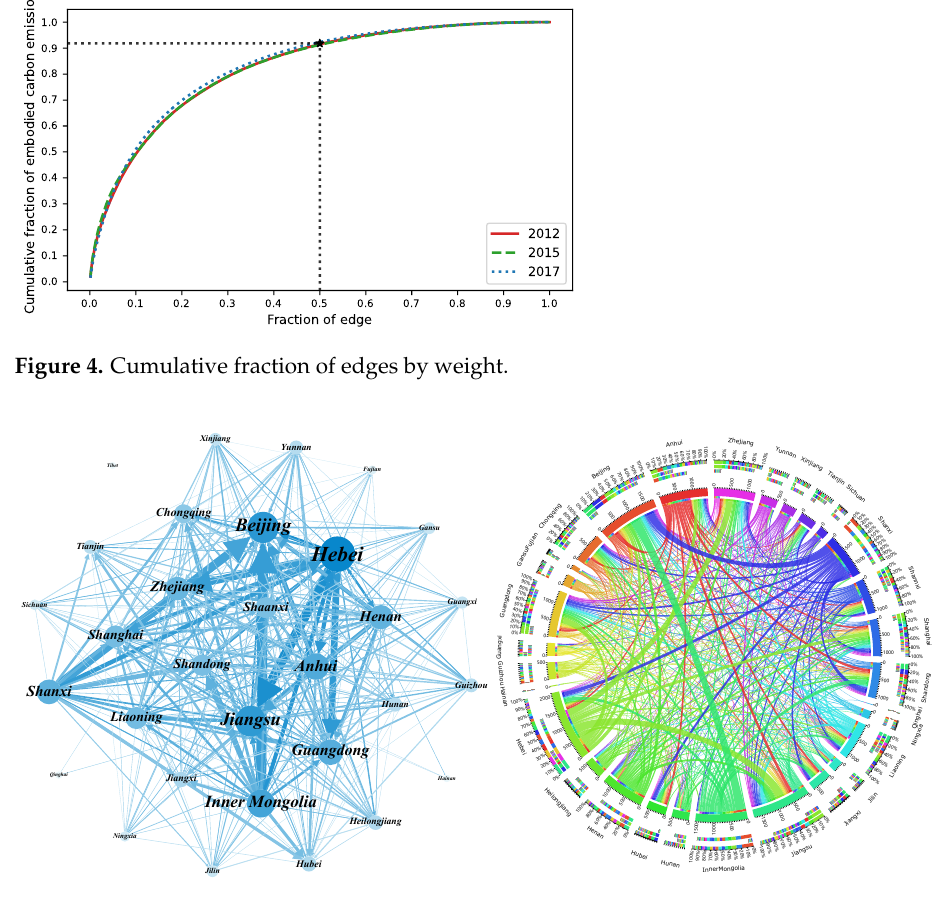
Figure 5. Inter-provincial embodied carbon emission transfers in